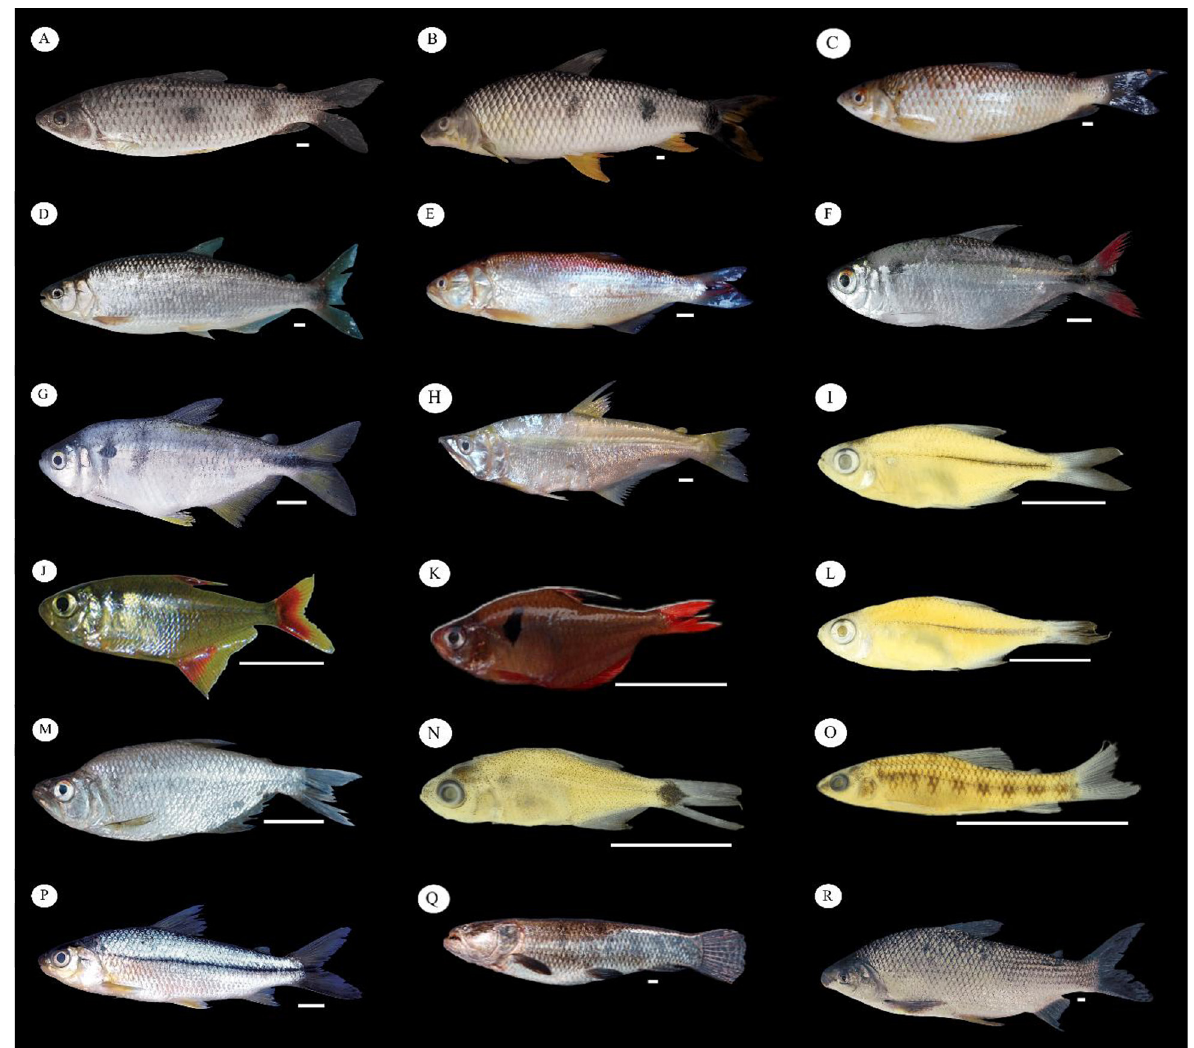
Figure 5. Representative samples of fish species collected in Rio Santa Bárbara, Sapucaí-Mirim/Grande hydrographic basin, São Paulo state, Brazil. A. Leporinus friderici , LIRP 15795, 272.46 mm SL. B. Megaleporinus obtusidens , LIRP 15799, 428.00 mm SL. C. Schizodon nasutus , LIRP 15763, 310.50 mm SL. D. Brycon nattereri , LIRP 15717, 285.00 mm SL. E. Salminus hilarii , LIRP 15792, 185.00 mm SL. F. Astyanax fasciatus , LIRP 15719, 125.00 mm SL. G. Astyanax lacustris , LIRP 15754, 107.00 mm SL. H. Galeocharax gulo , LIRP 15762, 255.00 mm SL. I. Hemigrammus marginatus , LIRP 15746, 37.45 mm SL. J. Hyphessobrycon bifasciatus , LIRP 15719, 32.72 mm SL. K. Hyphessobrycon eques , LIRP 15724, 25.91 mm SL . L. Moenkhausia intermedia , LIRP 15723, 34.60 mm SL. M. Oligosarcus pintoi , LIRP 15768, 51.47 mm SL. N. Serrapinnus notomelas , LIRP 15731, 26.79 mm SL . O. Characidium zebra , LIRP 15730, 18.77 mm SL. P. Steindachnerina insculpta , LIRP 15796, 115.00 mm SL. Q.